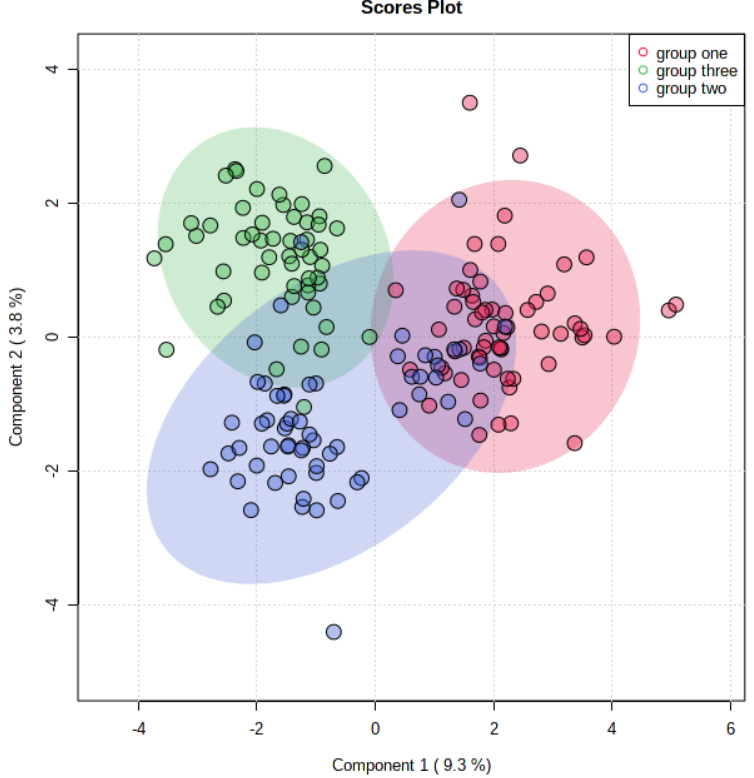
Figure 1. The sparse partial least squares-discriminant analysis (sPLS-Da) for all groups; group one: control; group two: normoglycemic MetS; group three: prediabetic MetS.